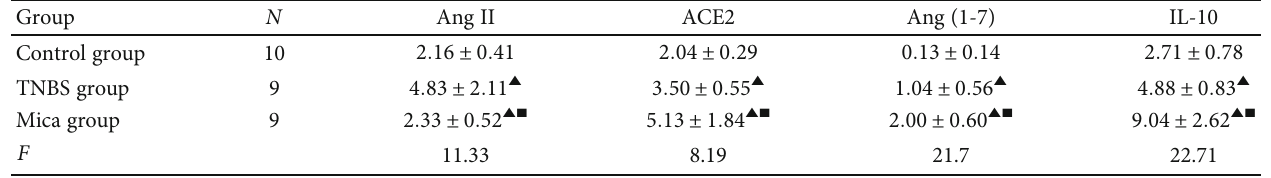
Figure 3: The expression of Ang II, ACE2, Ang (1-7), and IL-10 in di ff erent groups, × 200. Table 7: The expression of Ang II, ACE2, Ang (1-7), and IL-10 in colon tissue.